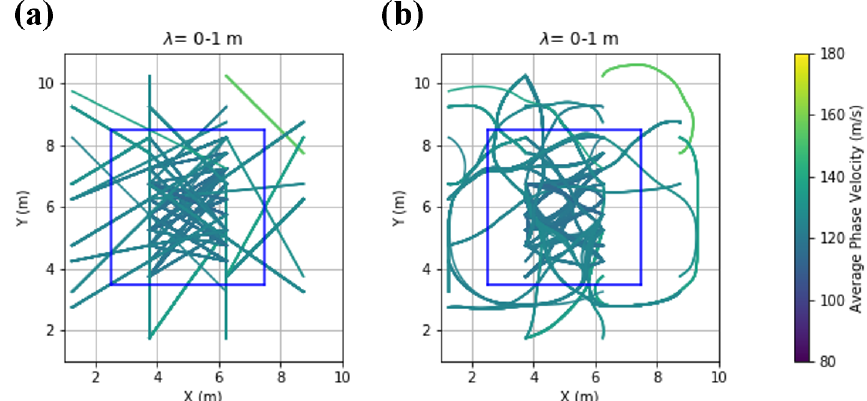
Figure 16. The ray paths for the data points of CNR example with wavelengths in the range of 0–1m from (a) the last iteration of the straight-ray and (b) the last iteration of curved-ray SWT inversions. The boundaries of the sand body at the surface are superimposed in blue. The colours of ray paths correspond to the computed path-averaged phase velocity along the path. Table 4. The quantitative comparison of straight-ray (SR) and curved-ray (CR) SWT of the various case studies. Sand Bar Blocky CNR Pijnacker d CR −